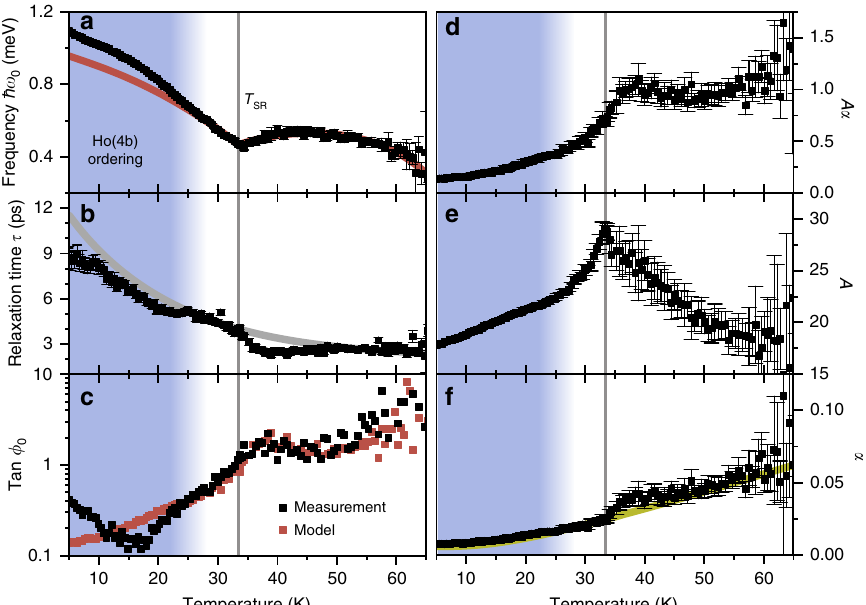
Fig. 3 Temperature-dependent Z -mode characterisation in HoMnO 3 . a Frequency, b relaxation time, and c tangent of the initial phase of the optically induced spin precession as function of temperature. Red: model calculations (see Methods section). In the blue-shaded region ≲ 25 K, incipient ordering of the Ho(4b) moments leads to discrepancies between data and the model (see Supplementary Fig. 3). Grey line: exponential decay as guide to the eye. d Exchange-enhanced damping parameter A α extracted from Z -mode frequency and relaxation time (Eqs. (4) and (5)). e Temperature-dependent aspect ratio A of the spin-precession ellipses. f Resulting Gilbert damping parameter α . Yellow line: function proportional to Bose-Einstein distribution with quasiparticle energy of 4.3 meV.